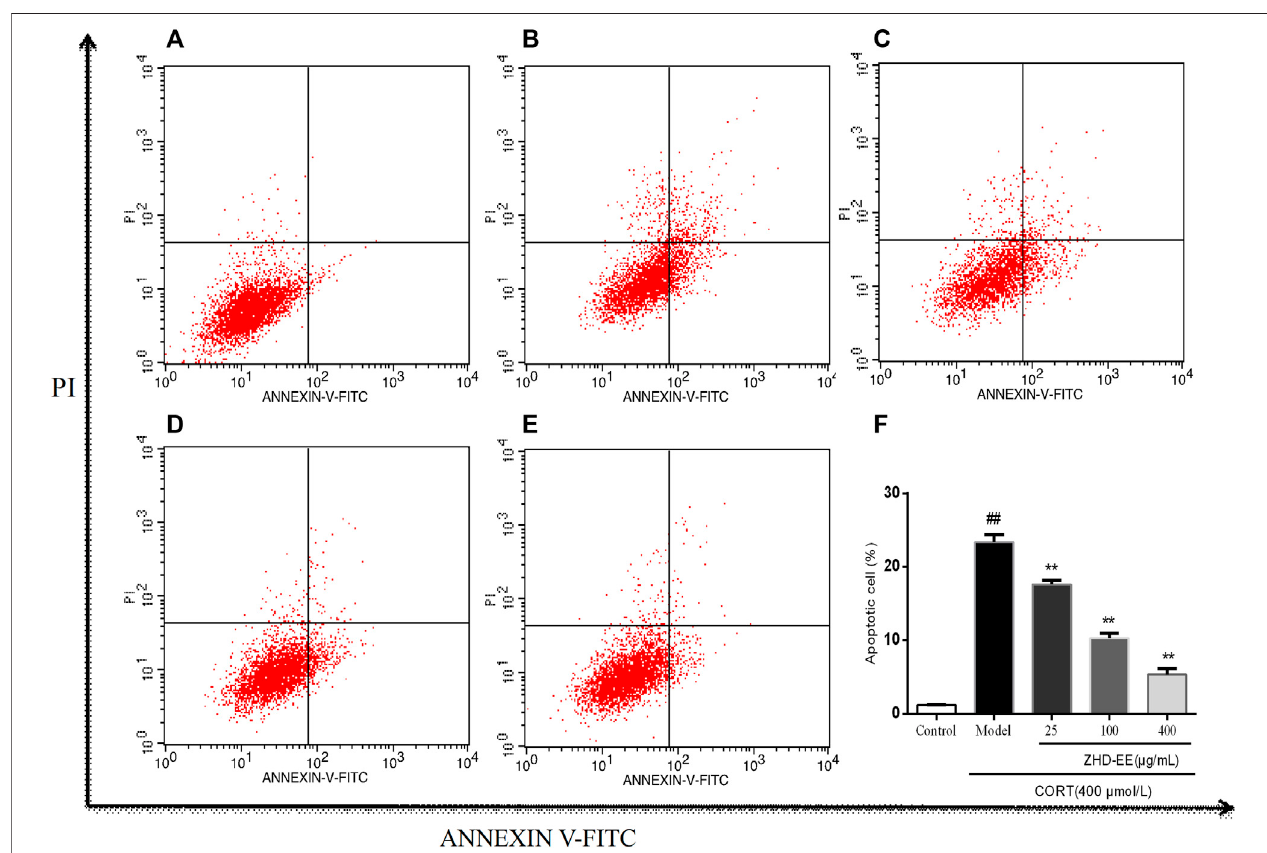
FIGURE 5 | Effects of ZHD-EE on the cell apoptotic rates in CORT-treated PC12 cells by Annexin V-FITC/PI double staining with fl ow cytometry. (A) : Normal cell; (B) :PC12celllesionedby400 μ MCORT; (C − E) :PC12 celltreatedby25,100,400 μ g · mL − 1 ZHD-EEand400 μ MCORT. (F) :thehistogramofcellapoptosis rate. ## p < 0.01 compared with the control group, ** p < 0.01 compared with the CORT-treated group. ZHD-EE: ethanol extract of ZHD.